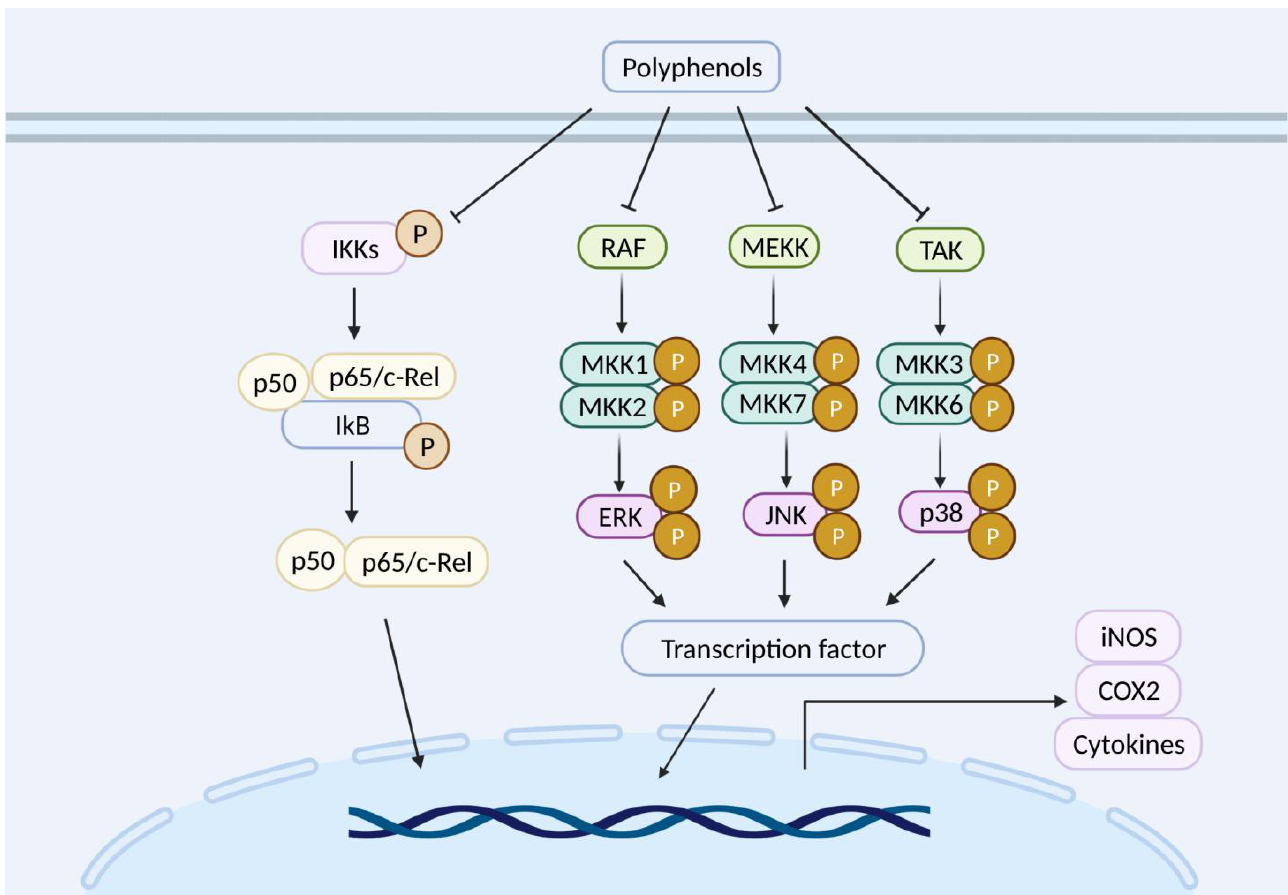
Figure 2. The potential anti-inflammatory mechanism of polyphenols. COX2: cyclooxygenase-II; ERK: extra-cellular signal regulated kinases; IKKs: IkB-kinase; iNOS: inducible nitric oxide synthase; JNK: c-Jun amino-terminal kinases; MEKK: mitogen-activated protein kinase kinase kinase; MKK: mitogen-activated protein kinase kinase; NF-kB: nuclear factor kappa-light-chain-enhancer of activated B cells; RAF: Raf kinases; TAK: Tak kinases.